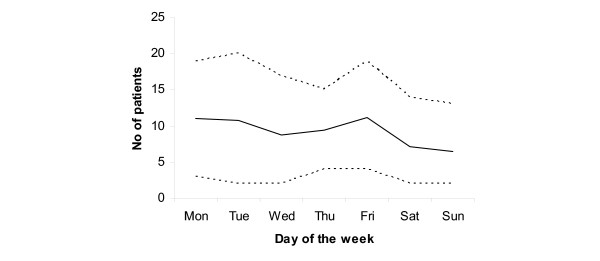
Average number of patients on different days of the week (Mon-Sun). Note 1: line – average number; scatter above line – 95th percentile; scatter below line – 5th percentile. Note 2: based on 1,714 patients (34 missing) for whom the exact date of attendance was available